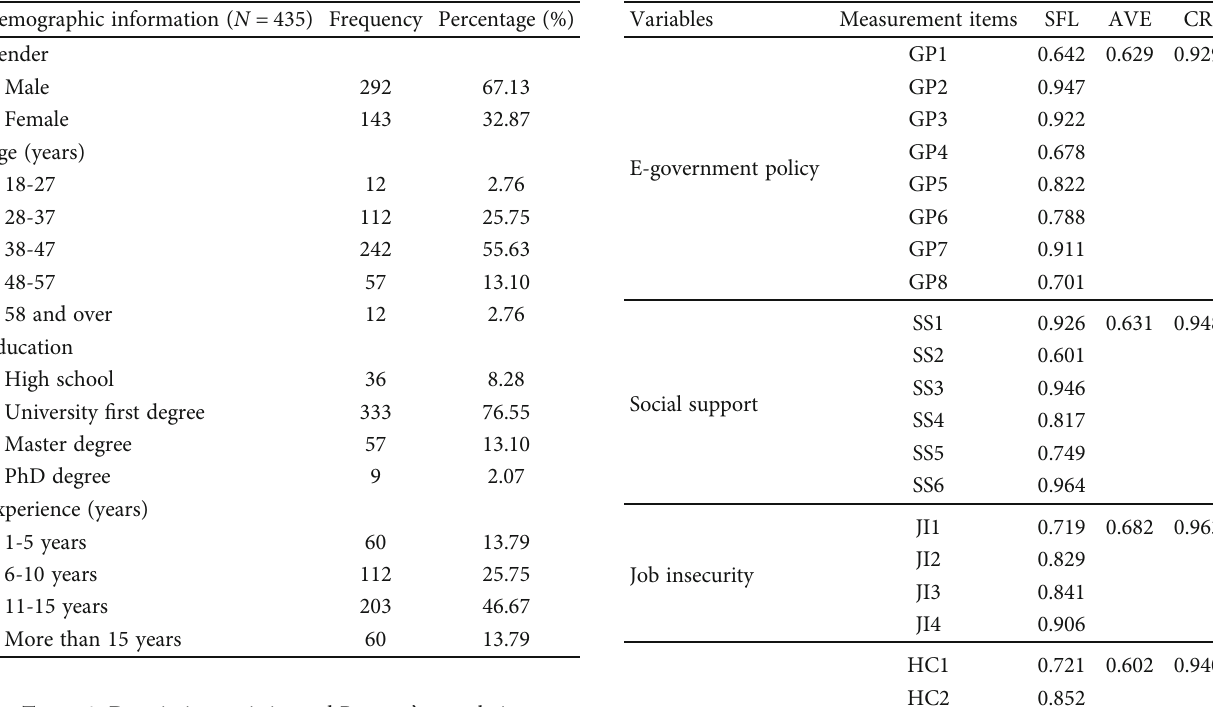
Table 3: Reliability and validity